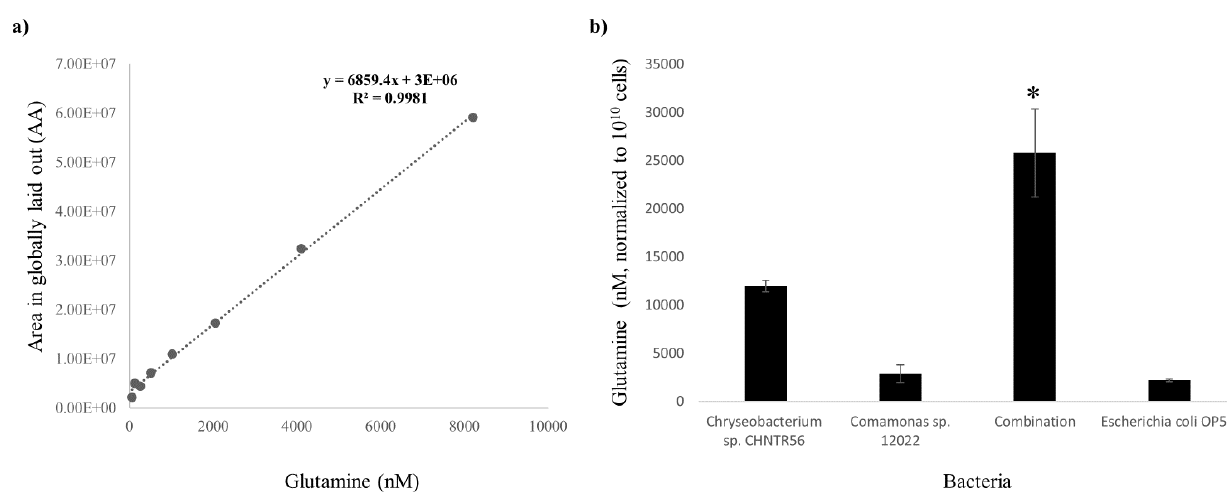
Figure 6. Abundance of glutamine in bacterial isolates. ( a ) Linear curve of standard glutamine ( m/z = 147.0764) with R 2 score is shown; ( b ) The abundance of glutamine (normalized to 10 10 cells) was estimated to be the highest in combination. *: p < 0.05.